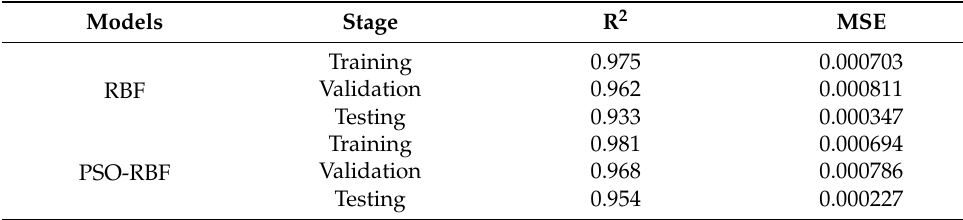
Table 6. Prediction performance results of the RBF and PSO-RBF models.